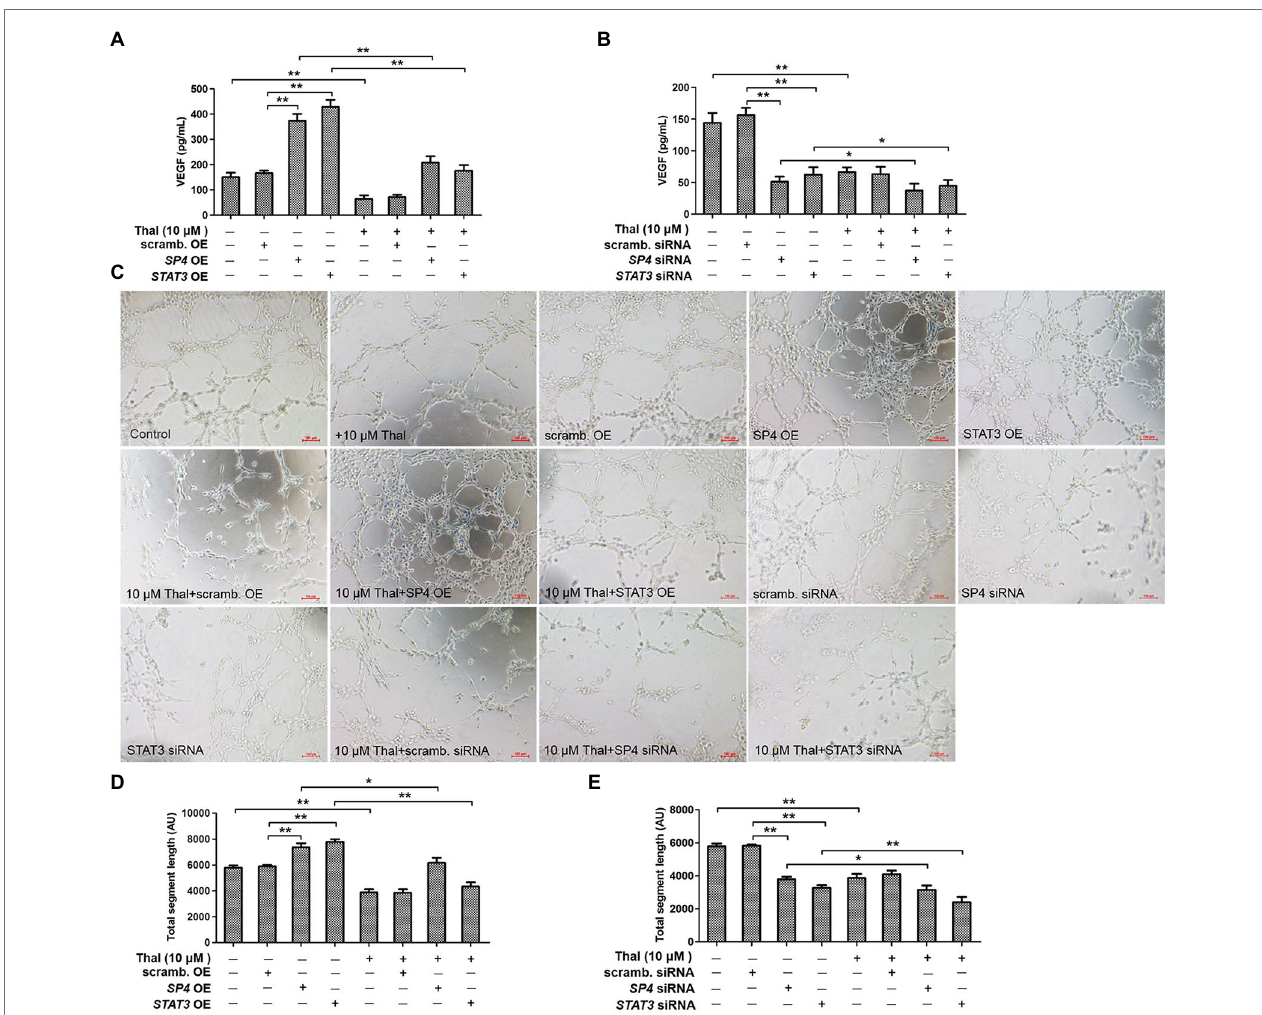
FIGURE 3 | Effect of thalidomide on VEGF–mediated endothelial cell tube formation. VEGF secretion was assessed in HPMCs transiently transfected with either SP4-OE, STAT3-OE, or scramb. OE (A) , either SP4 siRNA, STAT3 siRNA, or scramb. siRNA (B) , stimulated with thalidomide (10 μ M) for 24 h. (C) Effect of conditioned medium (10% vol/vol) from HPMCs treated as in (A,B) on endothelial cell tube formation within 16 h. (D,E) Quantification of total segment length is presented in order corresponding to experimental groups as shown in (C) . * p < 0.05; ** p <